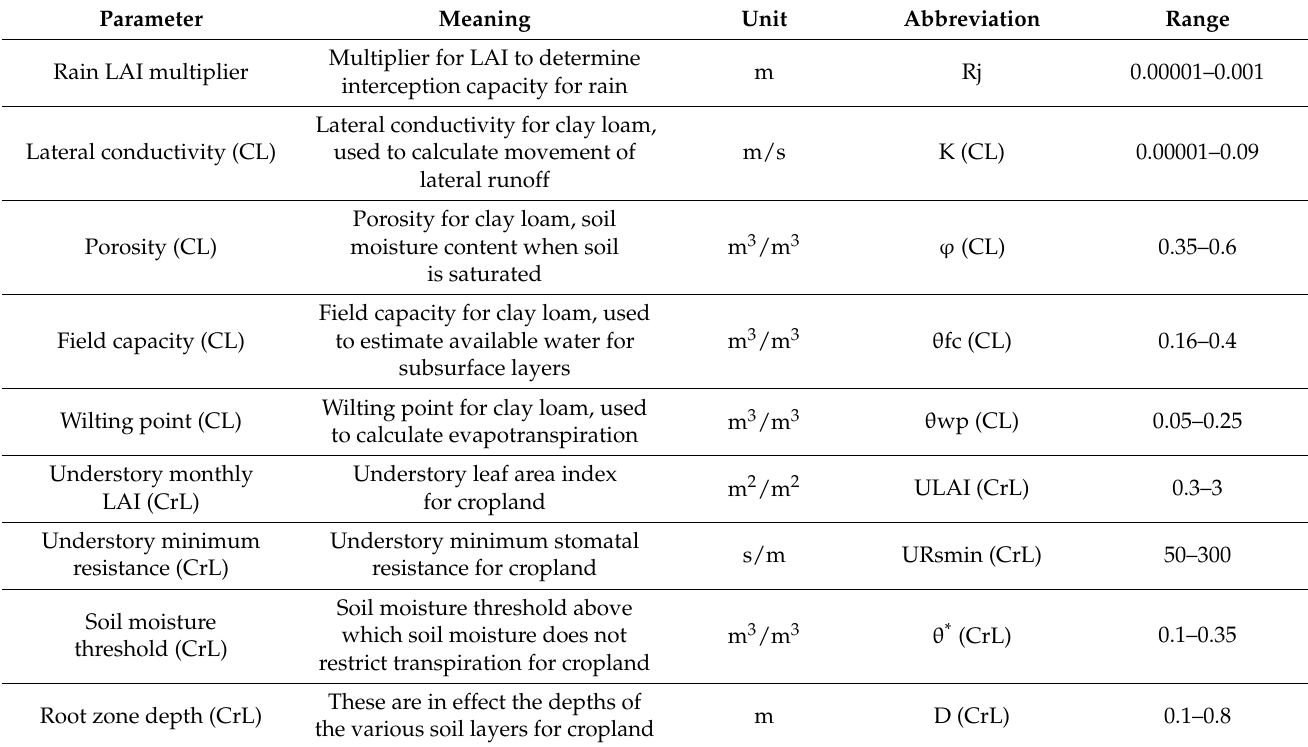
Table 1. Range, meaning, unit, and abbreviation of eight highly sensitive parameters for parameter